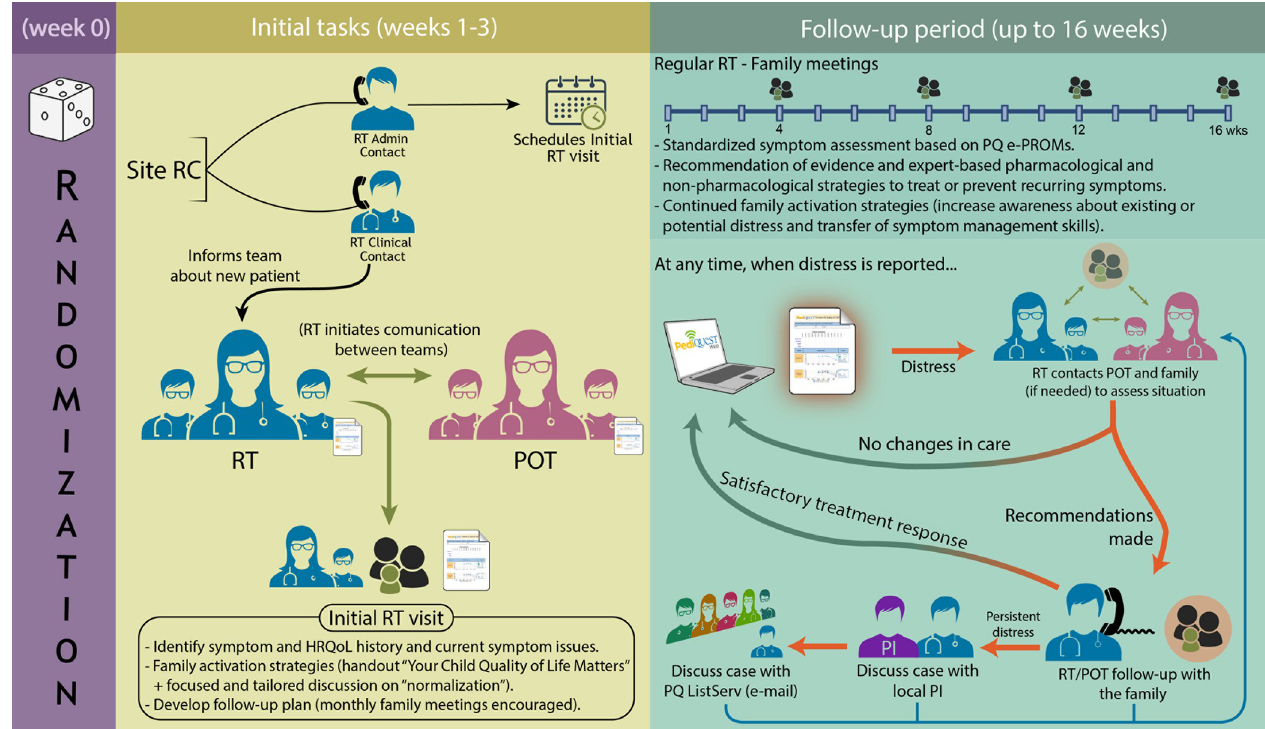
Fig 2. Main activities of the response team integration component. Abbreviations : RC : Research coordinator; RT : Response Team; POT : Primary Oncology Team; PQ e-PROMS : PediQUEST electronic patient reported outcome measures; Local PI : Site Principal Investigator; PQ ListServ : PediQUEST Listserv (expert